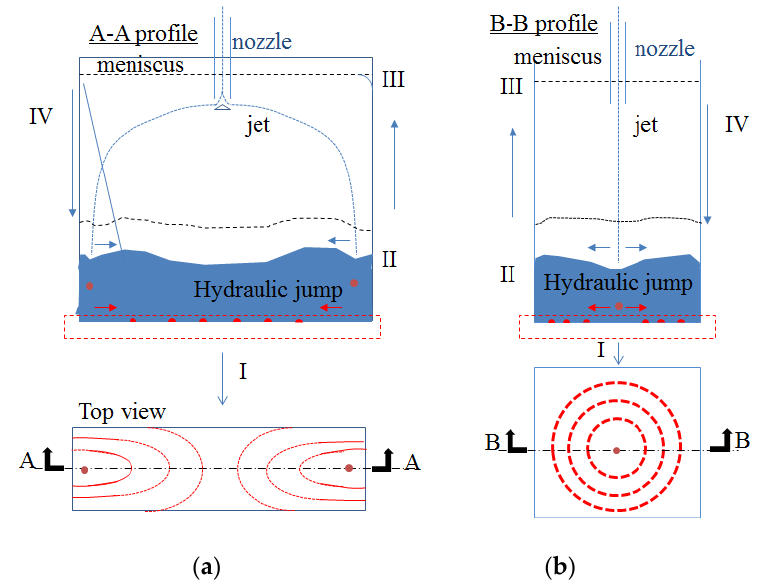
Figure 1. Hydraulic jump in the continuous process in the mold; ( a ) slab ( b ) bloom. (A-A profile is the profile at the centerline of the top view)